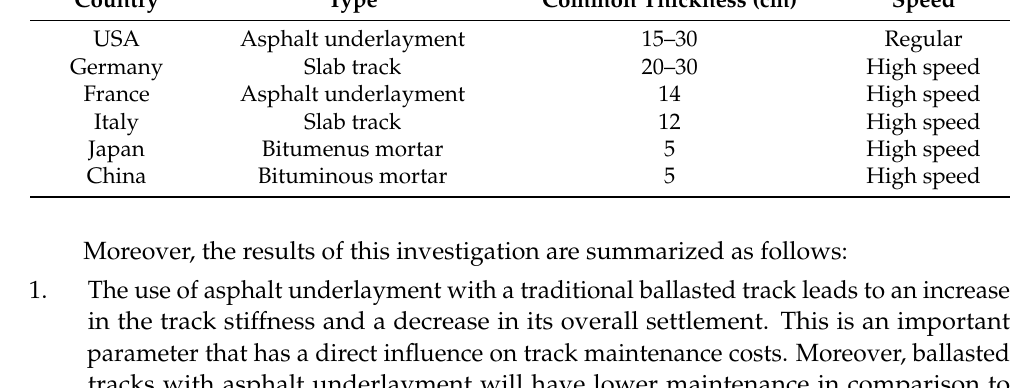
Table 7. Various applications of asphalt and bituminous materials under railways.